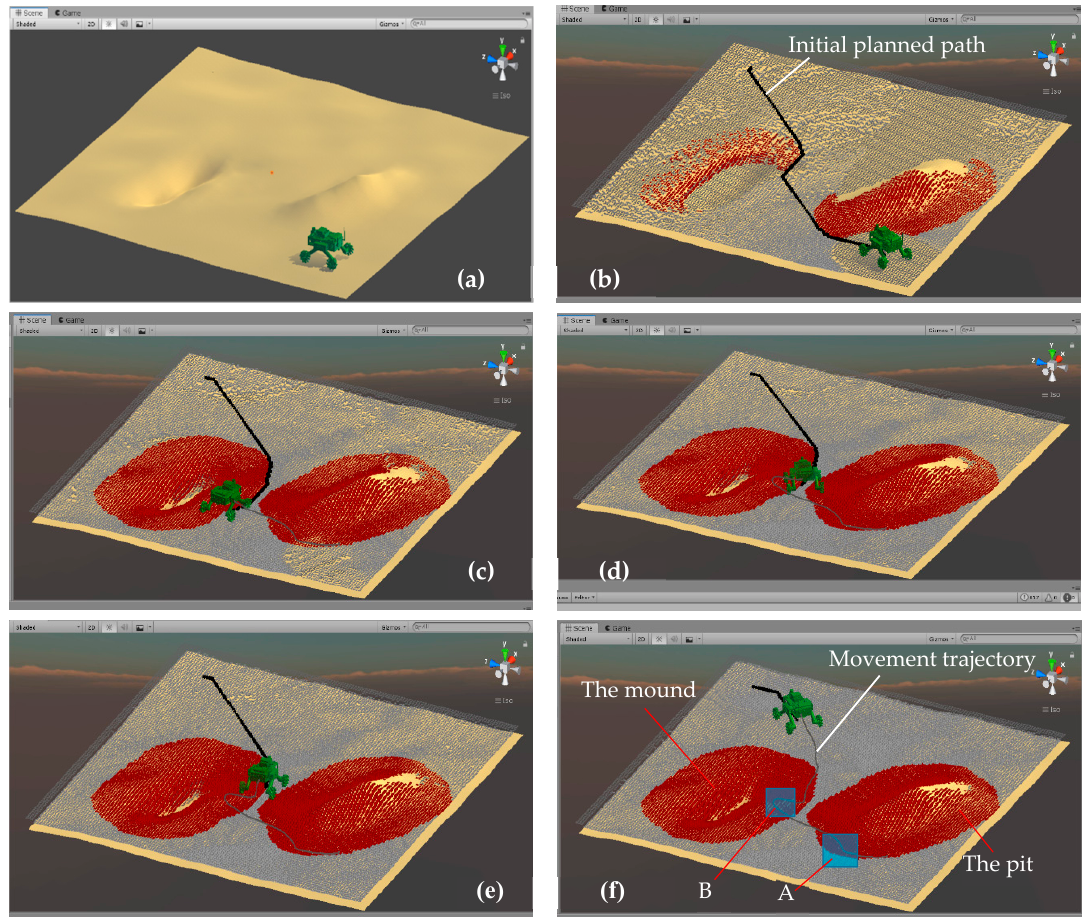
Figure 33. Navigation simulation of the robot on stochastic ground with a pit and a mound: ( a ) the simulated stochastic ground and robot model; ( b–f ) navigation simulation process of the robot. Sensors 2019 , 19 , x FOR PEER REVIEW